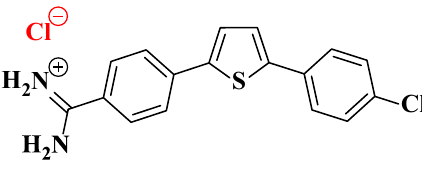
Fig. 1 2-(4-Amidinophenyl)- 5-(4-chlorophenyl)